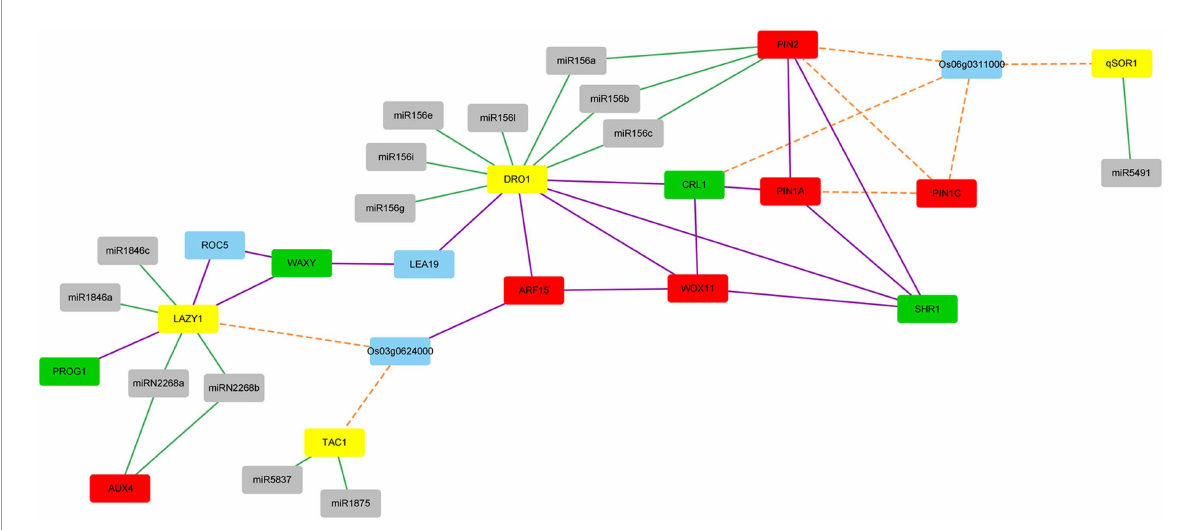
FIGURE7 The network among proteins from the IGT family, proteins involved in auxin response and root development and microRNAs. Interacting proteins were connected by purple lines. Proteins with co-expression patterns were linked by orange dot lines. microRNAs and its target genes were linked by green lines. The IGT family proteins were represented by yellow nodes. Proteins involved in auxin response were represented by red nodes, while proteins involved in root development were represented by green nodes, microRNAs were represented by gray nodes, other proteins were represented by blue nodes.